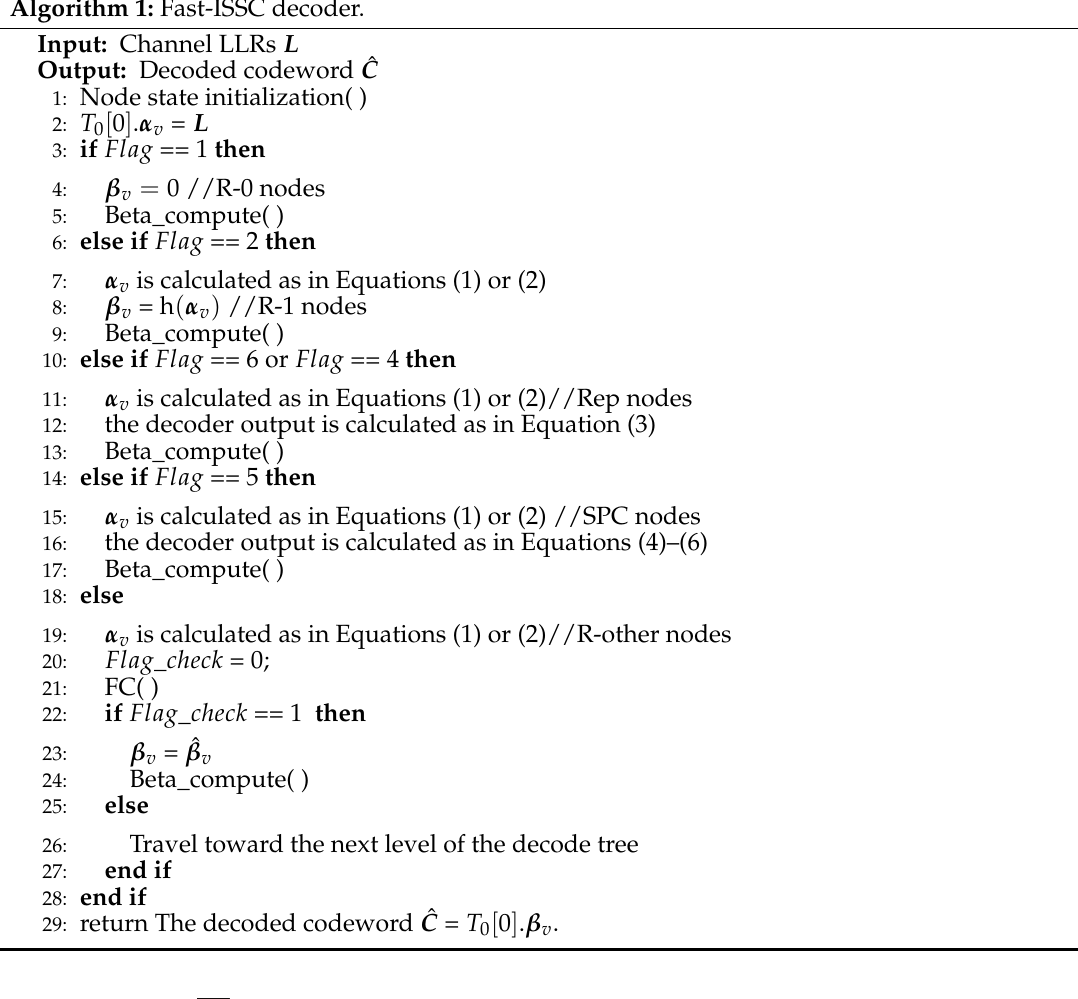
Algorithm 1: Fast-ISSC decoder.